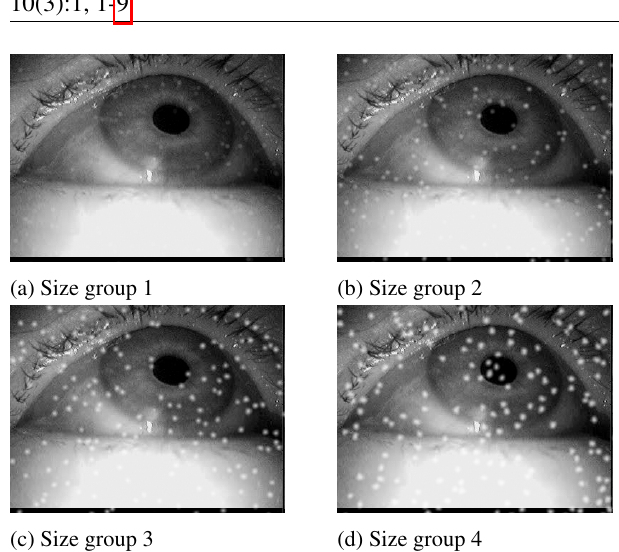
Figure 6 . Simulation results for di ff erent particle size groups on one image. The particle amount is set to 200 and the focal length is 5.6.